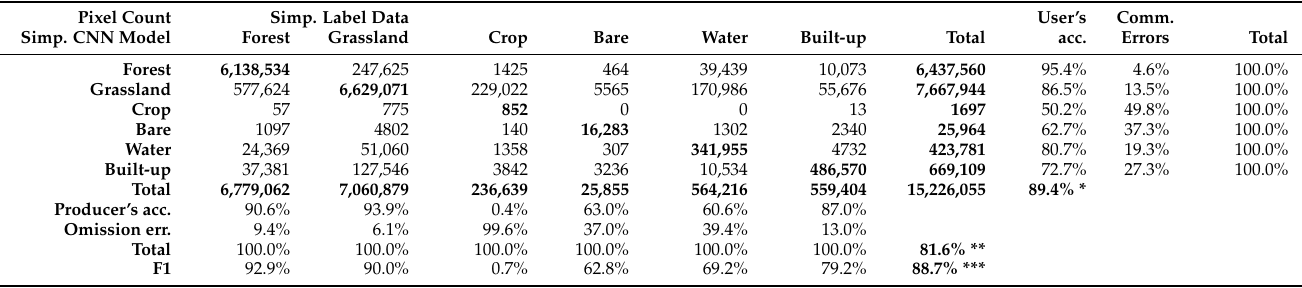
Table 8. Simplified U-Net CNN model vs. simplified label data for 2018. OA = 89%, Kappa = 82% and weighted-mean F1 = 89%. Excludes No data pixels.